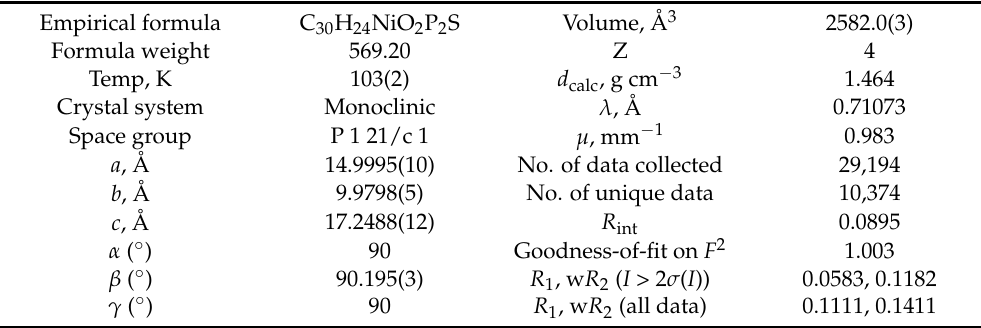
Table 2. Summary of crystal data and structure refinement for complex 1c